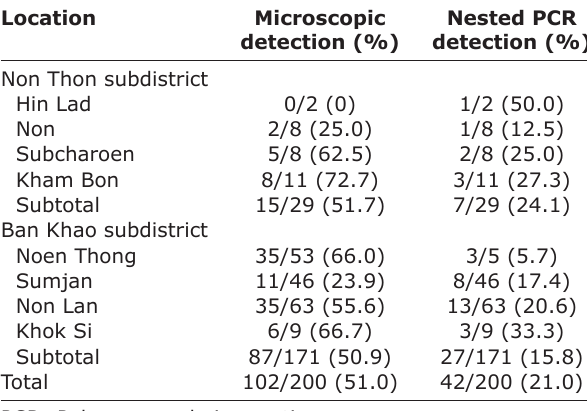
Table-1: Cryptosporidium spp. infection rate of newborn dairy calves in eight